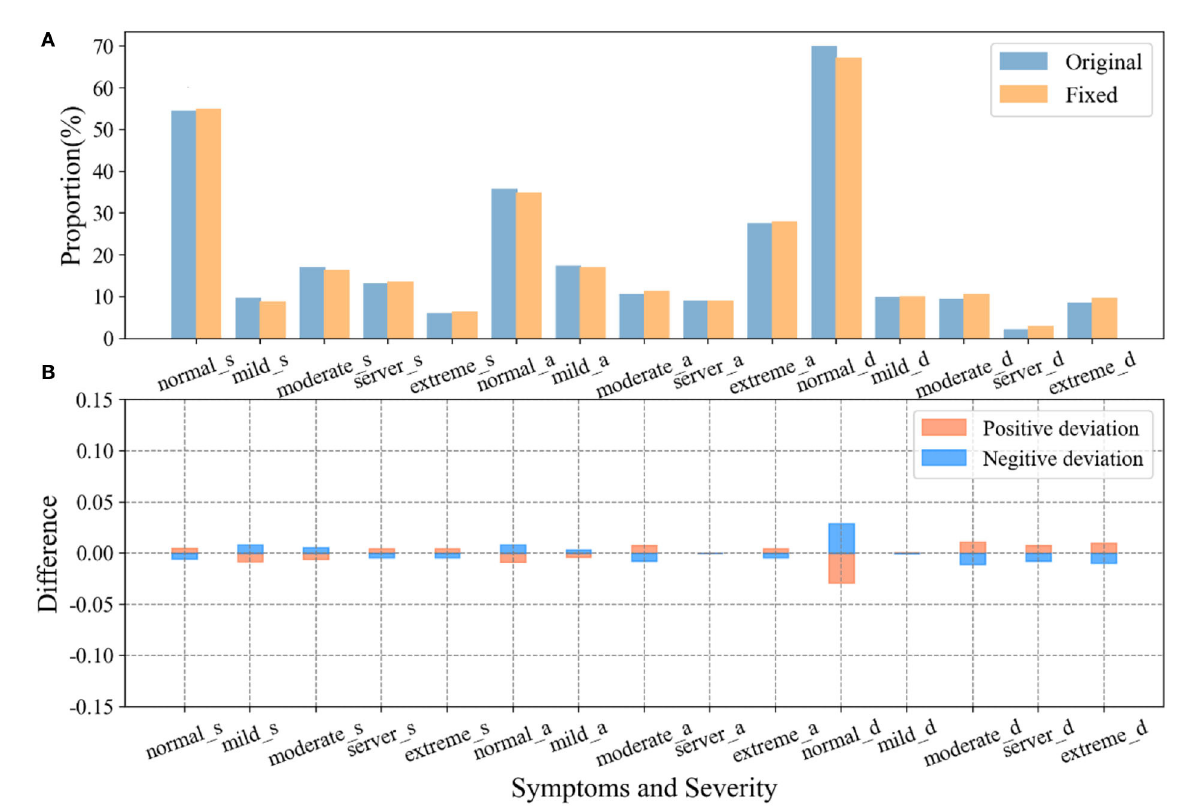
FIGURE5 Evaluation results after correction and comparison with those before correction. (A) DASS-21 scales the proportion of different severity of stress, anxiety, and depressive symptoms before and after correction; (B) Bias in the proportion of symptom severity before and after